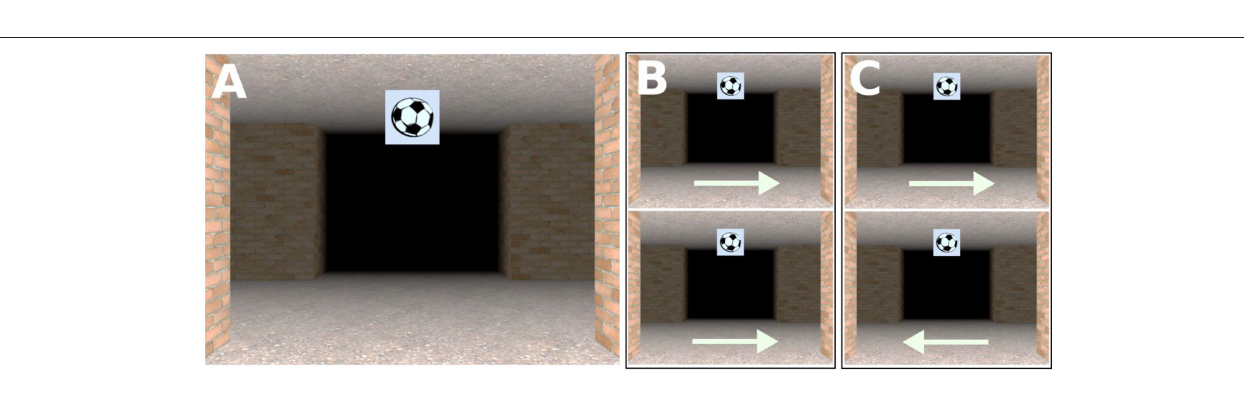
FIGURE 2 | (A) Screenshot taken at an intersection. The landmark object associated with that intersection is the picture of a football suspended from the ceiling; (B) Non-unique same direction intersections; the route continues in the same direction at the intersections with the same landmark object; (C) Non-unique different direction intersection; the route continues in the different direction at the intersections with the same landmark